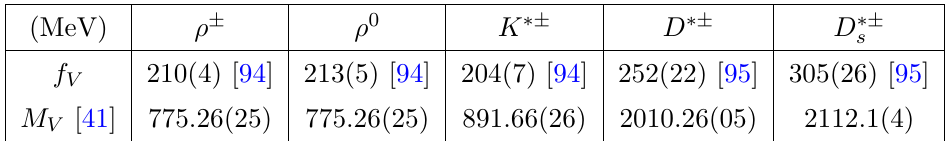
vector meson states (the values for the ( s )